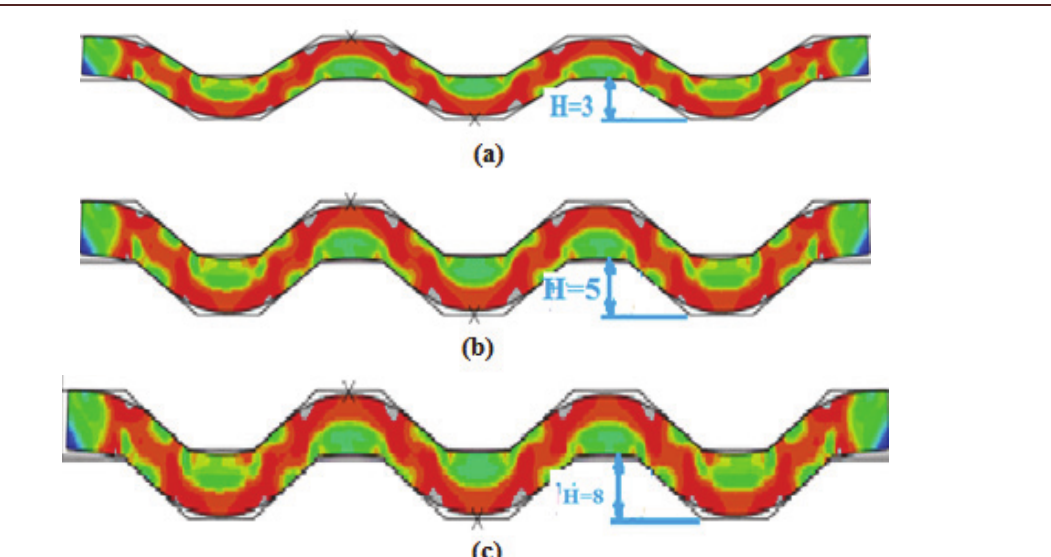
Figure 17: Illustration of three configurations of the matrices by varying the depth of the groove: (a) H = 3mm, (b) H = 5mm, (c) H = 8mm.